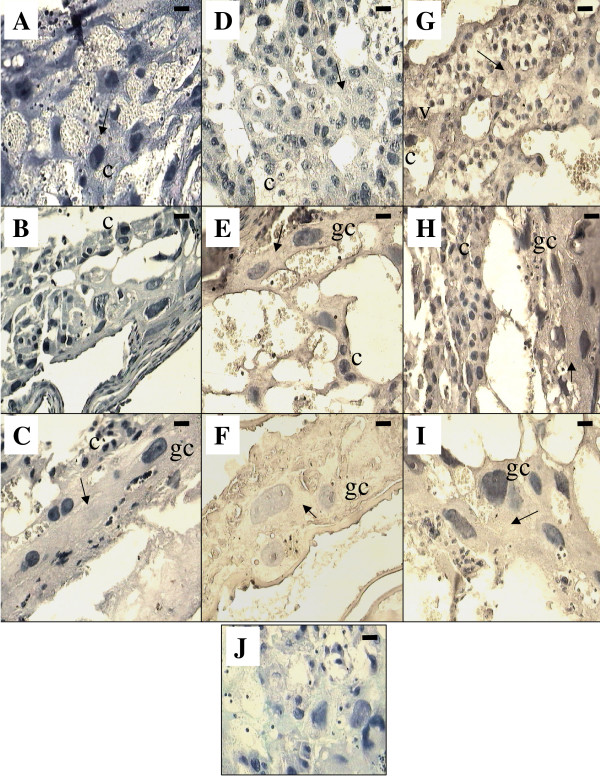
Immunohistochemical detection of cytosolic cytochrome-c in placental tissue in different stages of pregnancy (days 16, 19 and 21). Cytochrome-c was detected using a polyclonal antibody (Santa Cruz Biotechnology, diluted 1:100) followed by incubation with a biotinylated anti-goat antibody (1:500) and reaction with DAB in the presence of H2O2. The arrows indicate the cytoplasmic immunostaining of cytochrome-c in trophoblastic cells. The tissue section contains cytotrophoblastic cells (c), trophoblastic giant cells (gc) and vesicular glycogen cells (v). Groups: C – control rats, corresponding to images A, B and C on the 16th, 19th and 21st day, respectively, W – tumour-bearing rats, corresponding to images D, E and F on the 16th, 19th and 21st day, respectively, and A – rats injected with ascitic fluid, corresponding to images G, H and I on the 16th, 19th and 21st day, respectively. Image J is a negative control. Magnification – 40×. Horizontal bar = 10 μm.